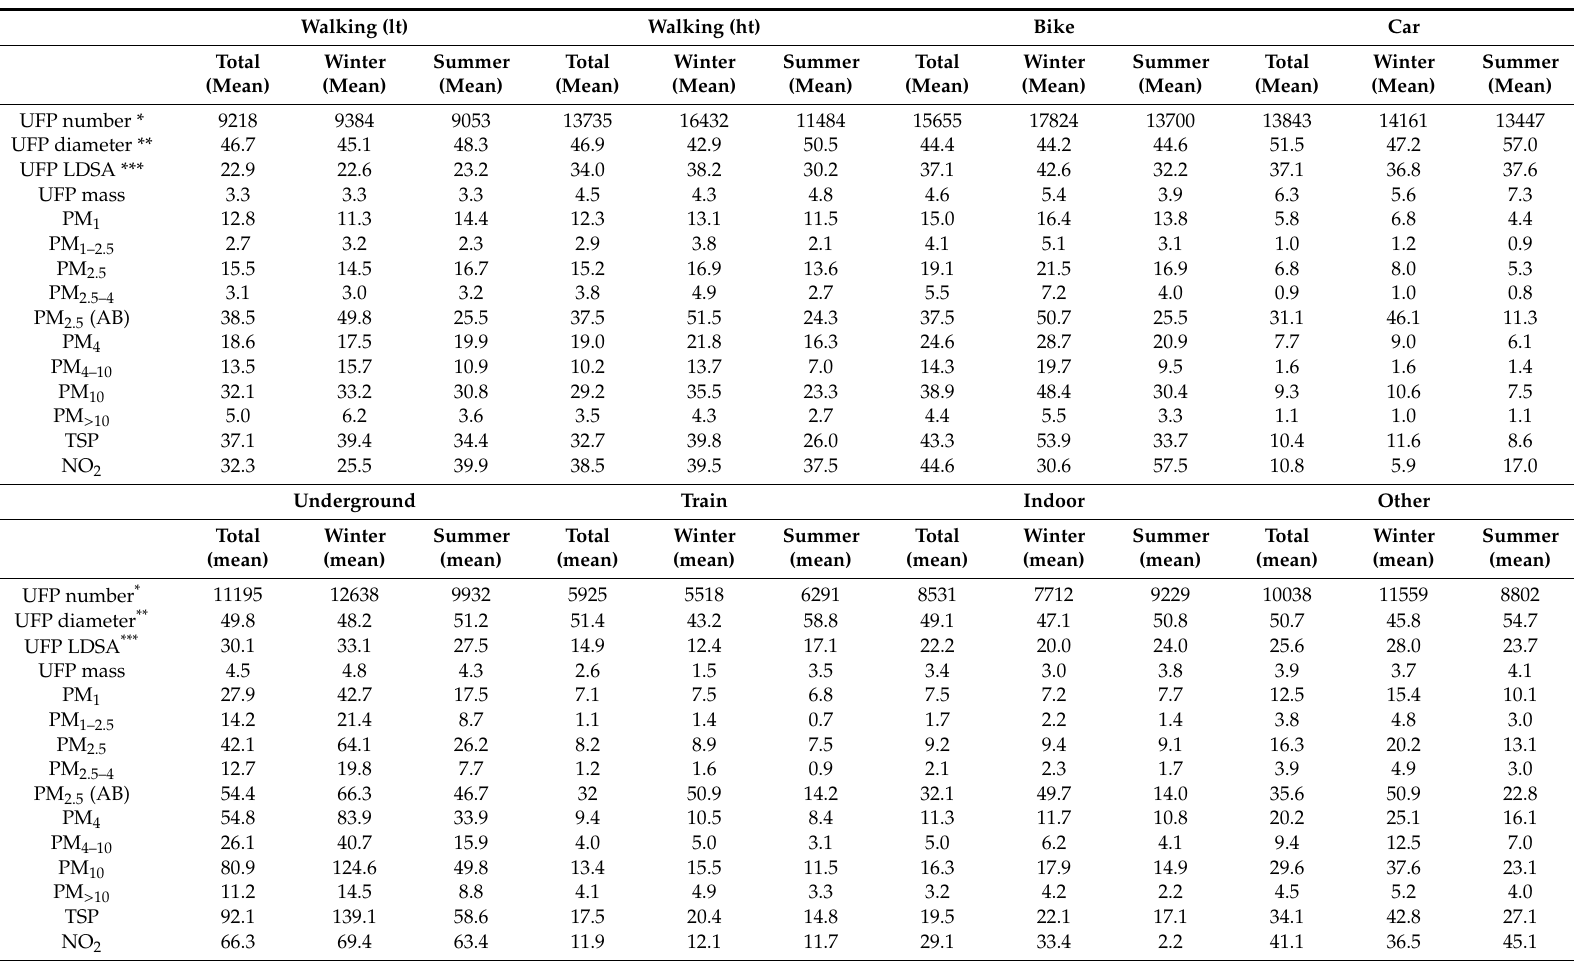
Table 2. Descriptive statistics (mean) of various microenvironments performed on the total dataset and for the winter and summer campaigns. Data are presented as µ g / m 3 (* particle / cm 3 ; ** nm; *** LDSA: lung deposited surface area, µ m 2 / cm 3 ; PM 2.5 (AB): PM 2.5 measured via AirBeam). Data in italics refer to those used for the calculation of ultrafine particle